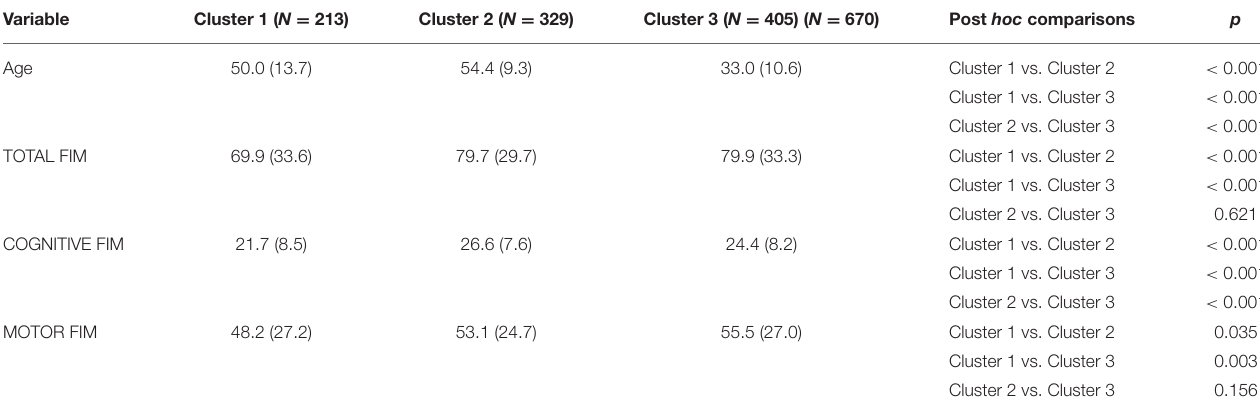
TABLE 7 | FIM post hoc analysis.